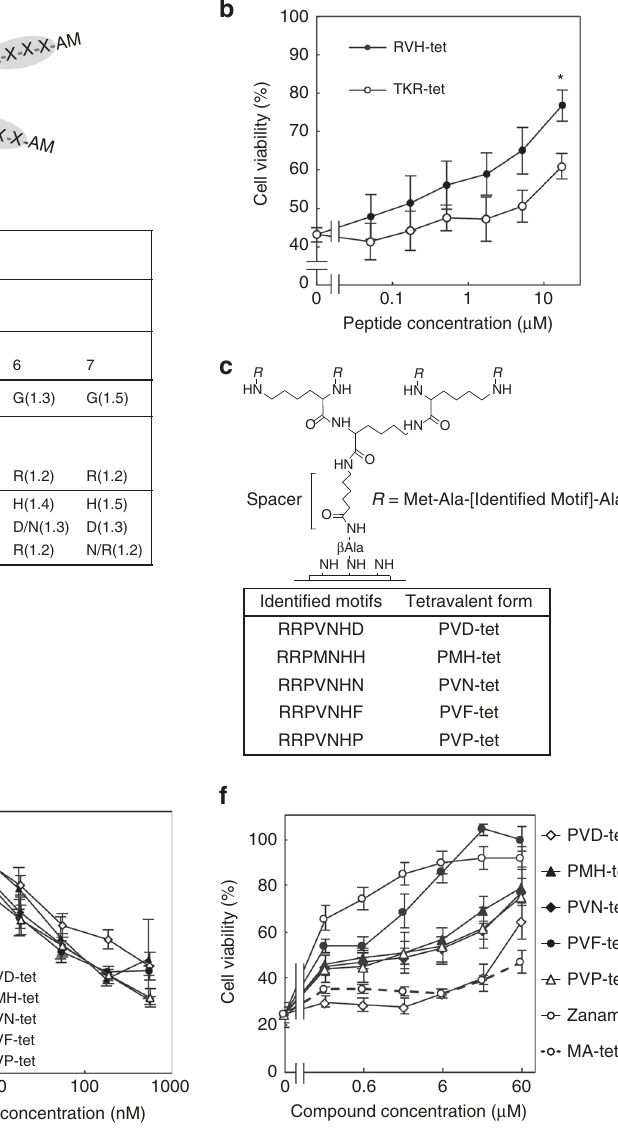
Fig. 1 Multivalent peptide library screen identi fi ed peptide-based HA inhibitors. a The tetravalent peptide library for the fi rst screen comprised tetravalent compounds with four randomized peptides of sequence Met-Ala-X-X-X-X-Ala-U (U; amino hexanoic acid), where X indicates any amino-acid except Cys. The library was screened to identify compounds that bound to HA but not to HA L194A. Three similar libraries with randomized peptides of sequence Met-Ala-X-X-X-(Gly/Lys/Val)-X-X-X-Ala-U were used for the second round of selections. Values in parentheses indicate the relative selectivity of the compound with indicated amino acids at the indicated positions. Each screen was performed twice; representative values are shown. b Two tetravalent peptides reduced IAV cytopathicity in MDCK cells. MDCK cells were infected with IAV strain PR8 at 10 MOI for 24 h in the presence of each peptide. Data are presented as a percentage of the control value without infection. * P < 0.05 (compared with TKR-tet by two-sided Student ’ s t test). c Structure of the tetravalent peptides synthesized on a cellulose membrane and optimized to HA. The density of the tetravalent peptide was set to 100% by using Fmoc- β -Ala-OH without Boc- β -Ala-OH for the fi rst peptide synthesis cycle, and the number of amino hexanoic acid residues (U; spacer length) was set to one. Five HA-binding motifs identi fi ed by two steps of af fi nity maturation screening of the membranes are shown (lower panel). d ELISA to measure the binding of each tetravalent peptide (2 μ M ) to recombinant HA. e AlphaScreen assay to examine the inhibitory effect of tetravalent peptides on the binding between HA and its receptor mimic, α 2 – 3-sialyllactose-PAA. Data are presented as a percentage of the control value. f The effects of tetravalent peptides and zanamivir on the IAV cytopathicity. MDCK cells were incubated with each compound for 30 min, and then infected with IAV strain PR8 at 10 MOI for 24 h. Data are presented as a percentage of the control value without infection. All data are from three independent experiments b and d – f , mean ± SEM). Source data are provided as a Source Data fi PVF-tet functions based on the clustering effect . We examined indicating that PVF-tet induces HA oligomer formation through intramolecular and intermolecular interactions. the kinetics of the binding of PVF-tet or its monomer peptide Consistently, PVF-mono showed no inhibitory effect on IAV (MARRPVNHFA; PVF-mono) to HA using the BIAcore cytopathicity when compared with PVF-tet (Fig. 2b), indicating system. PVF-tet, but not PVF-mono, bound to HA with that PVF-tet binds to HA and exerts its anti-IAV activity based high af fi nity (Fig. 2a). PVF-tet, but not PVF-mono, induced on the clustering effect. the formation of highly clustered HA (Supplementary Fig. 2),